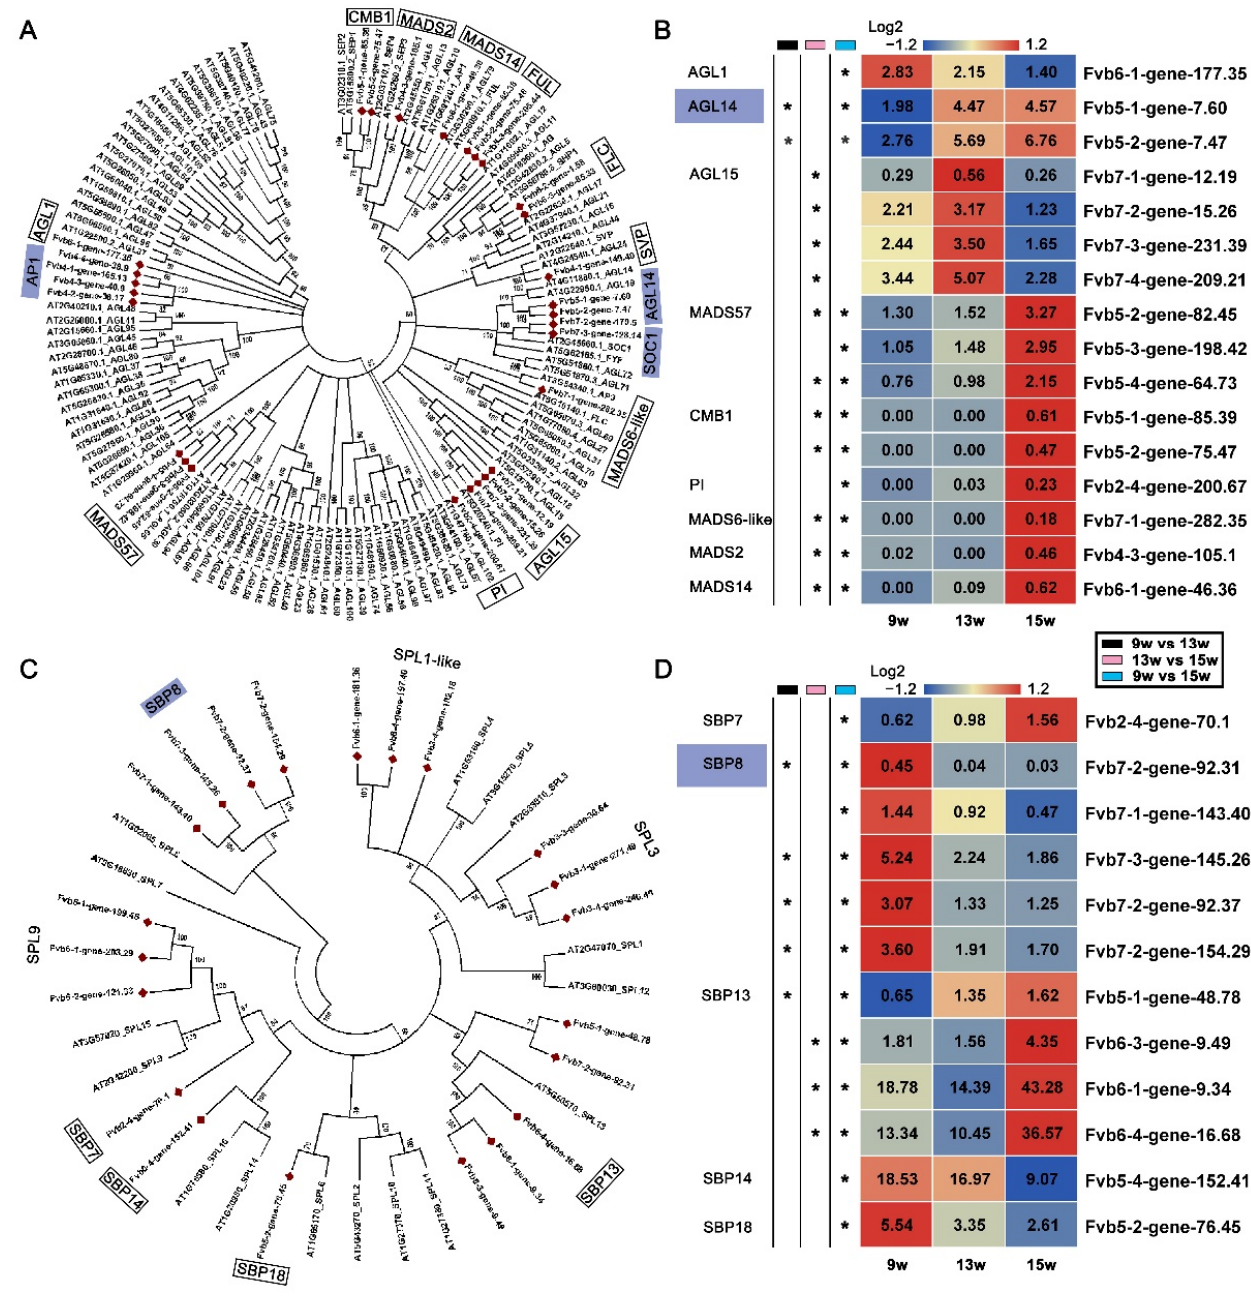
Figure 5. Phylogenetic analyses and relative expression of the DEGs in the MADS and SEB families. ( A ) Phylogenetic analysis of DEGs in the MADS family. ( B ) Heatmap showing the relative expression of DEGs in the MADS family. ( C ) Phylogenetic analysis of DEGs in the SEB family. ( D ) Heatmap showing the relative expression of DEGs in the SEB family. The purple boxes indicate the genes in which expression was significantly changed at 13 w. 9 w: vegetative stage; 13 w: shifts to reproductive stage at gene level; 15 w: reproductive stage. The column with the black boxes represents the student’s t test analysis of DEGs at 9 w vs. 13 w; The column with the pink boxes represents the student’s t test analysis of DEGs at 13 w vs. 15 w; The column with the blue boxes represents the student’s t test analysis of DEGs at 9 w vs. 15 w. (* |Log2FC| ≥ 1, p < 0.05).